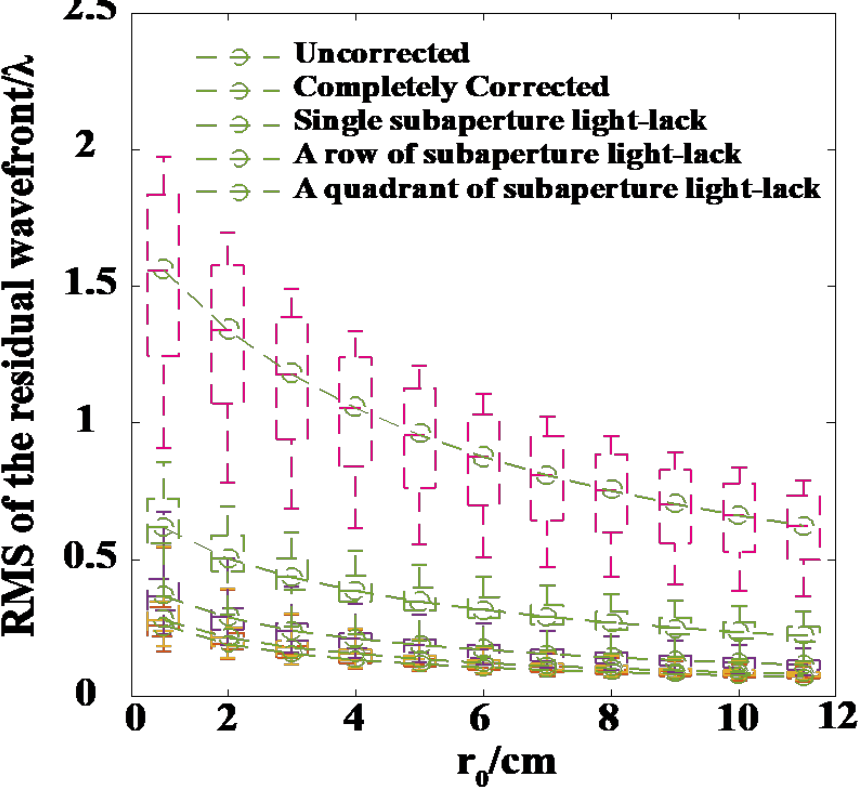
Figure 8. For the case of turbulence aberration, RMS of the residual wavefront varies with different values of r 0 under the conditions of uncorrected, completely corrected, single sub-aperture lack of light, a row of sub-apertures lack of light, and a quadrant of sub-apertures lack of light. Compared with the uncorrected result, the RMS can be reduced by a factor of 5~8, 4~6, and 2~3 at the condition of a single sub-aperture lack of light, a row of sub-apertures lack of light, and a quadrant of sub-apertures lack of